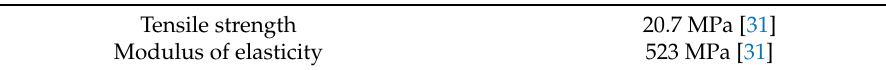
Table 2. Properties of the epoxy matrix.